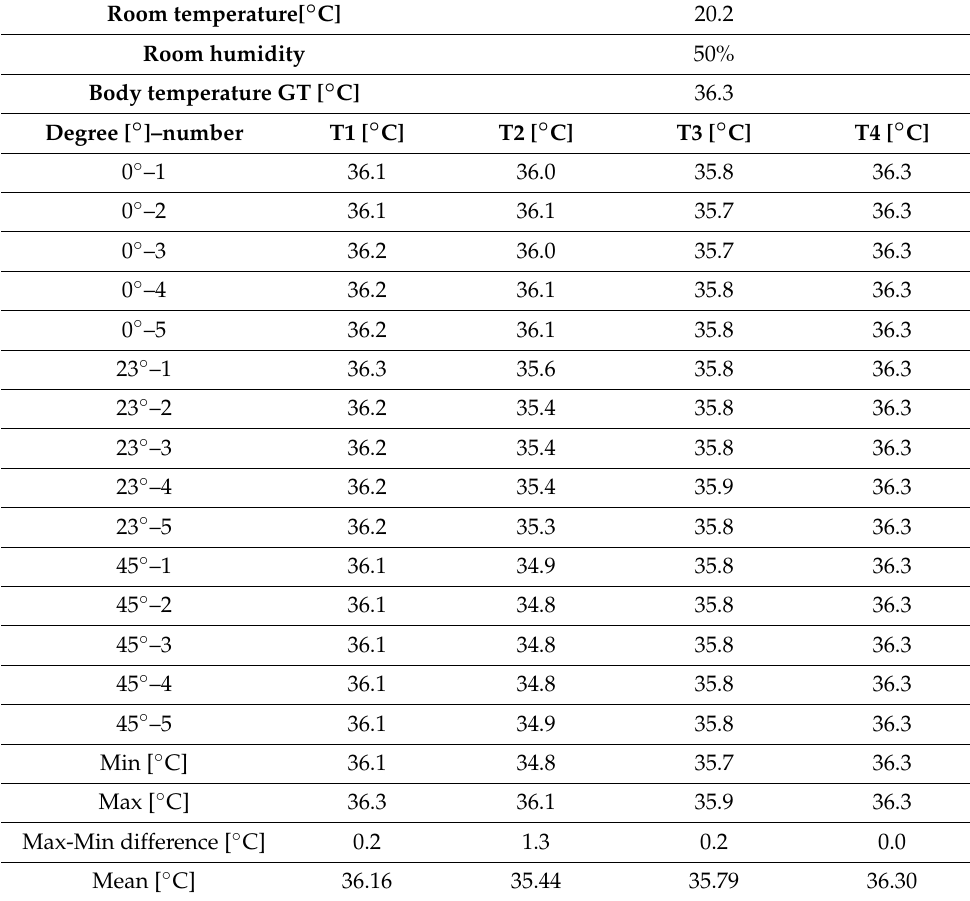
Table A8. Body–device angle experiment. Subject 2 body temperature data.